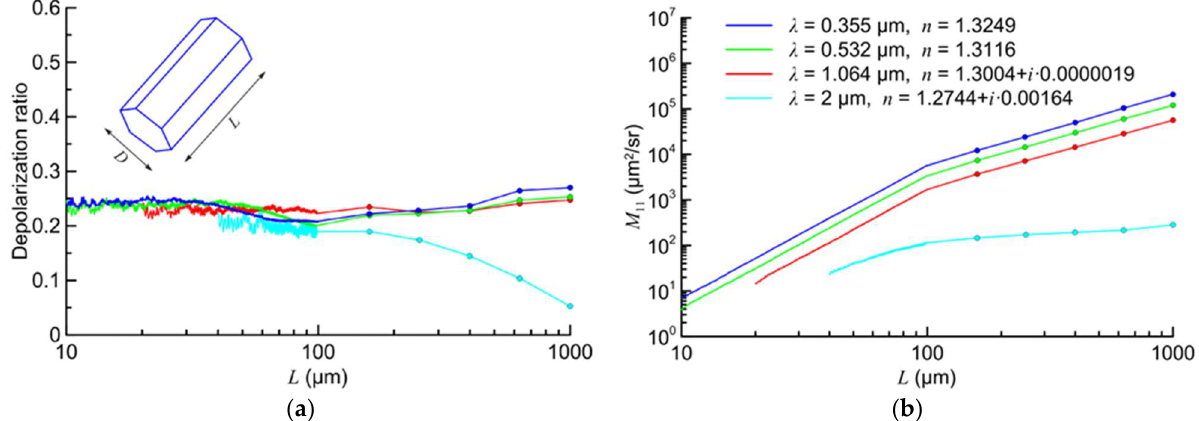
Figure 5. Depolarization ratio δ ( a ) and backscattering cross section M 11 ( b ) for hexagonal column at the conventional lidar wavelengths.